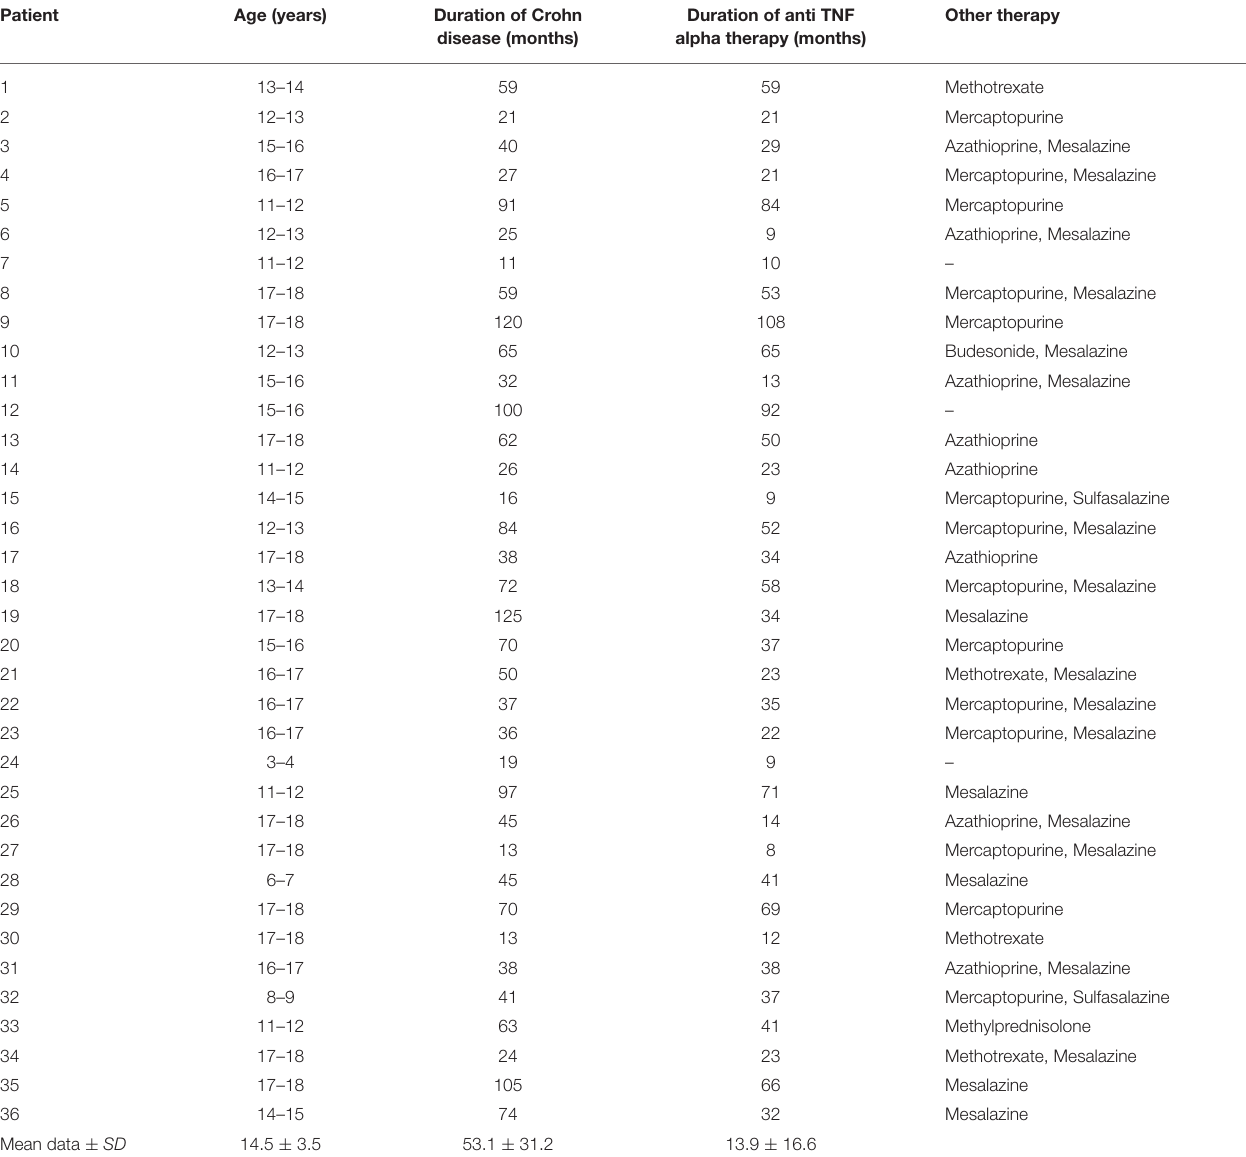
TABLE 1 | The detailed characteristic of the study group—patients treated with anti-TNF alpha. Patient